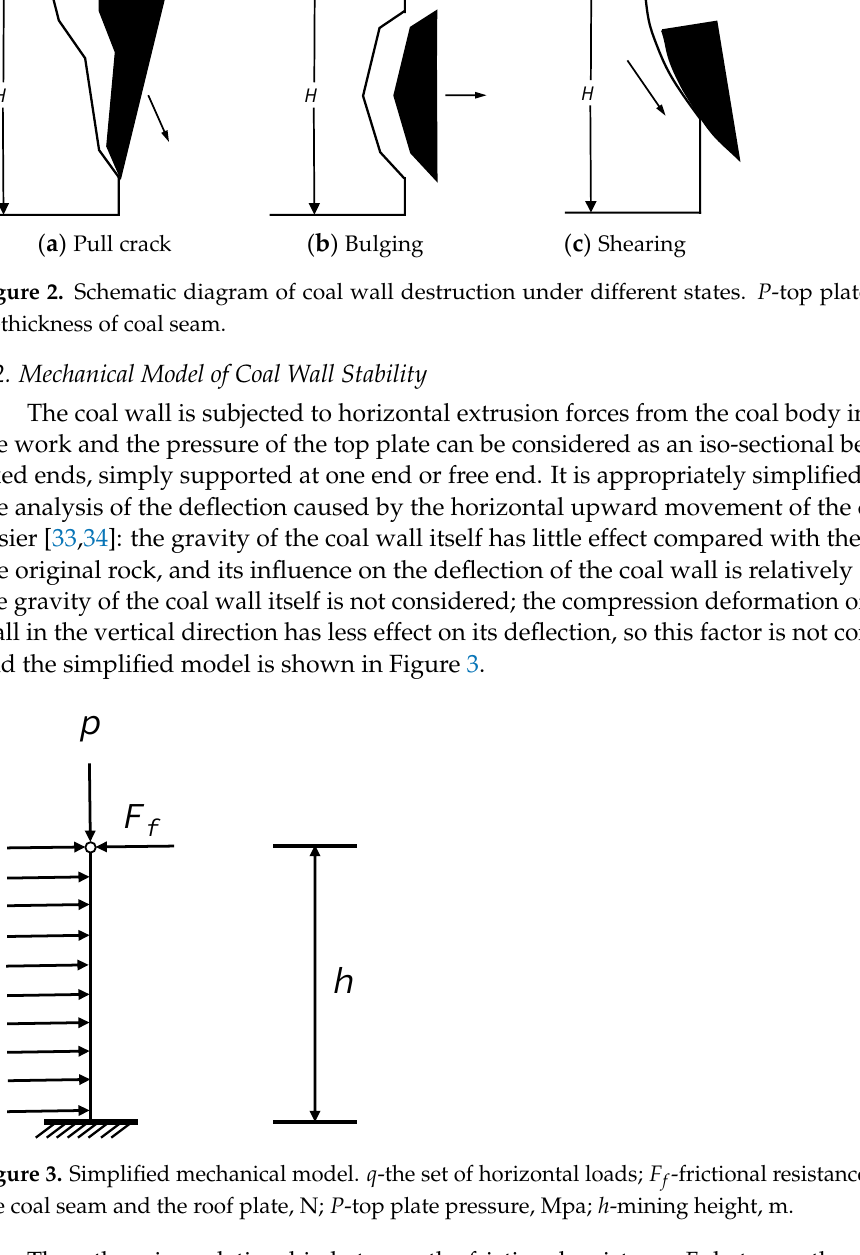
q -the set of horizontal loads; f